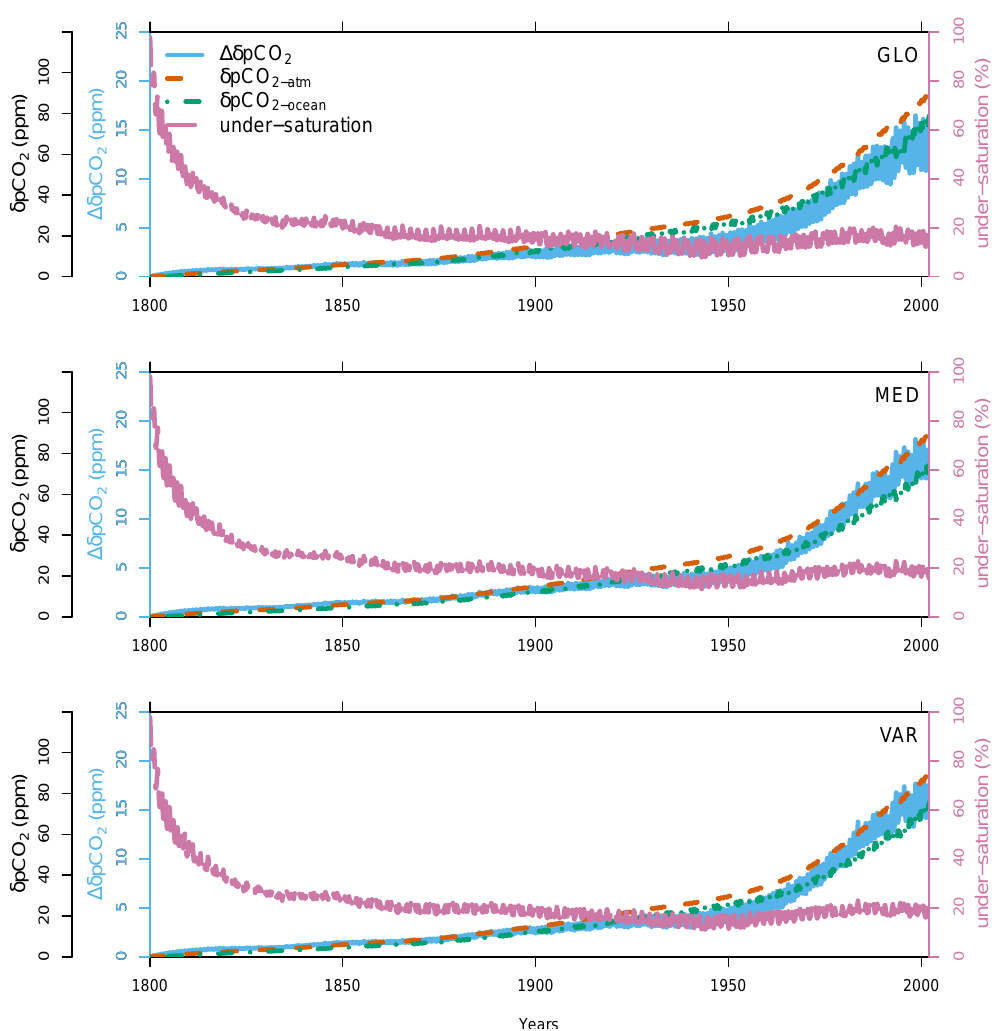
Figure 14. Temporal evolution from 1800 to 2001 of spatially averaged δp CO 2 (in ppm) in the atmosphere (dashed orange line), the ocean (dashed-dotted green line), and their difference (cid:49)δp CO 2 (solid light-blue line). Also shown is the corresponding percent undersaturation of (cid:16) (cid:17) oceanic δp CO 2 (purple line), defined as 100 1 − δp CO 2oc δp CO 2atm